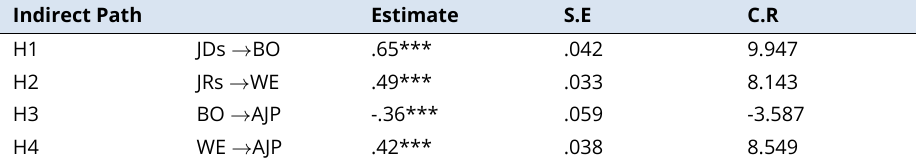
Summary of direct effects Indirect Path